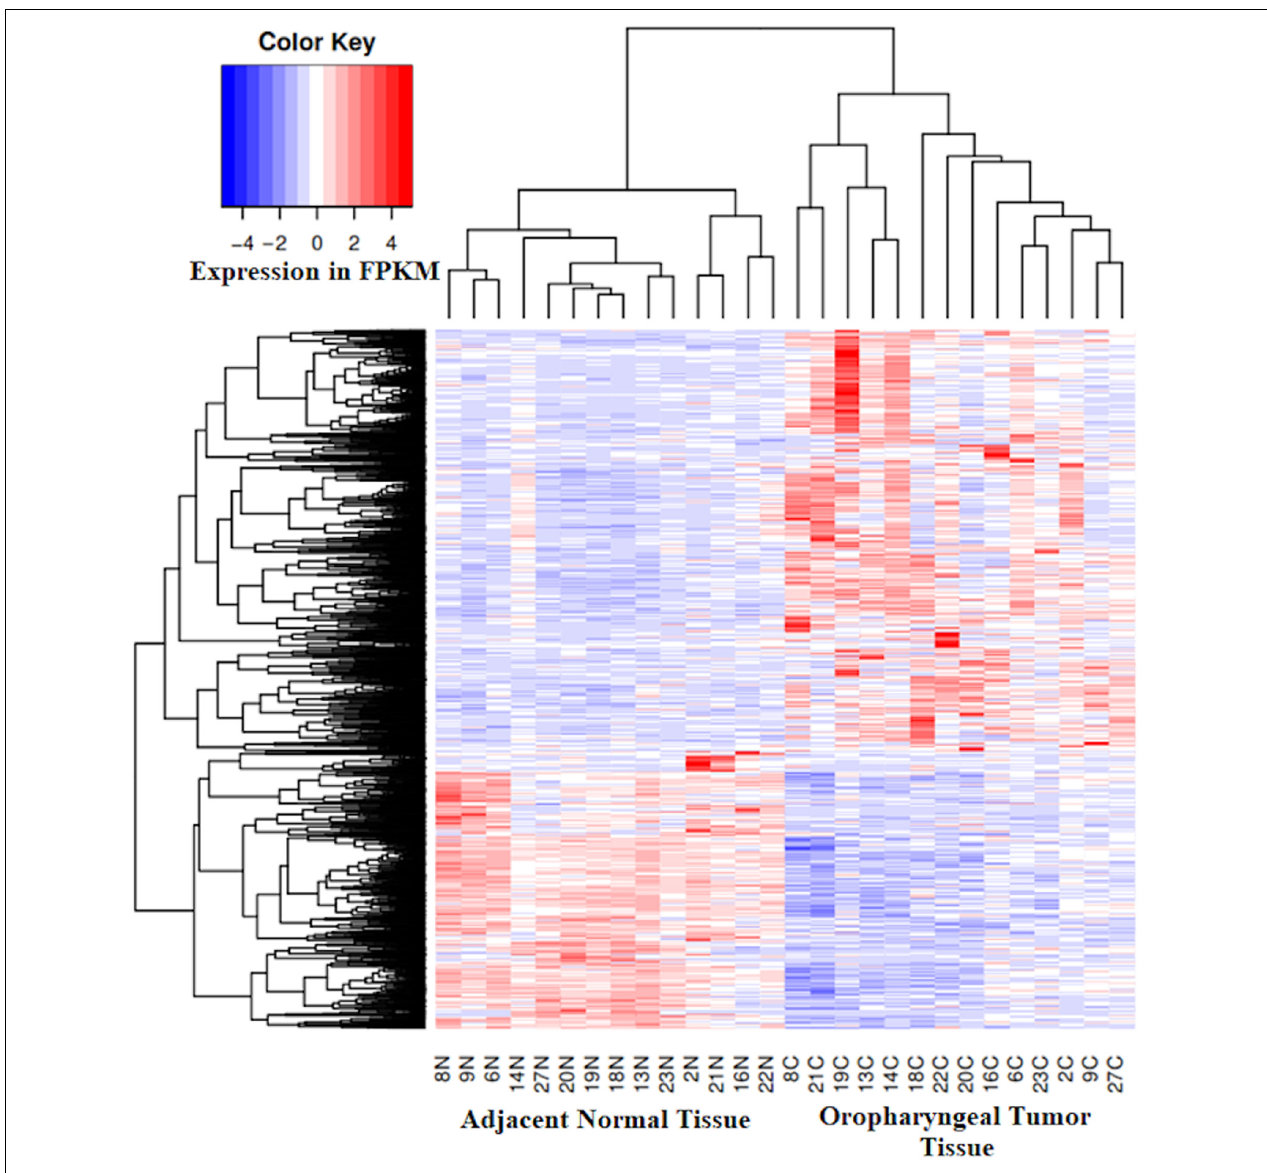
FIGURE 4 | Expression heatmap of 3,120 genes in the tumor tissue and the matched adjacent normal tissue shows overexpressed (1,850 genes, Red) and underexpressed (1270 genes, Blue) genes in the tumor tissue from oropharyngeal cancer patients with respect to paired adjacent normal